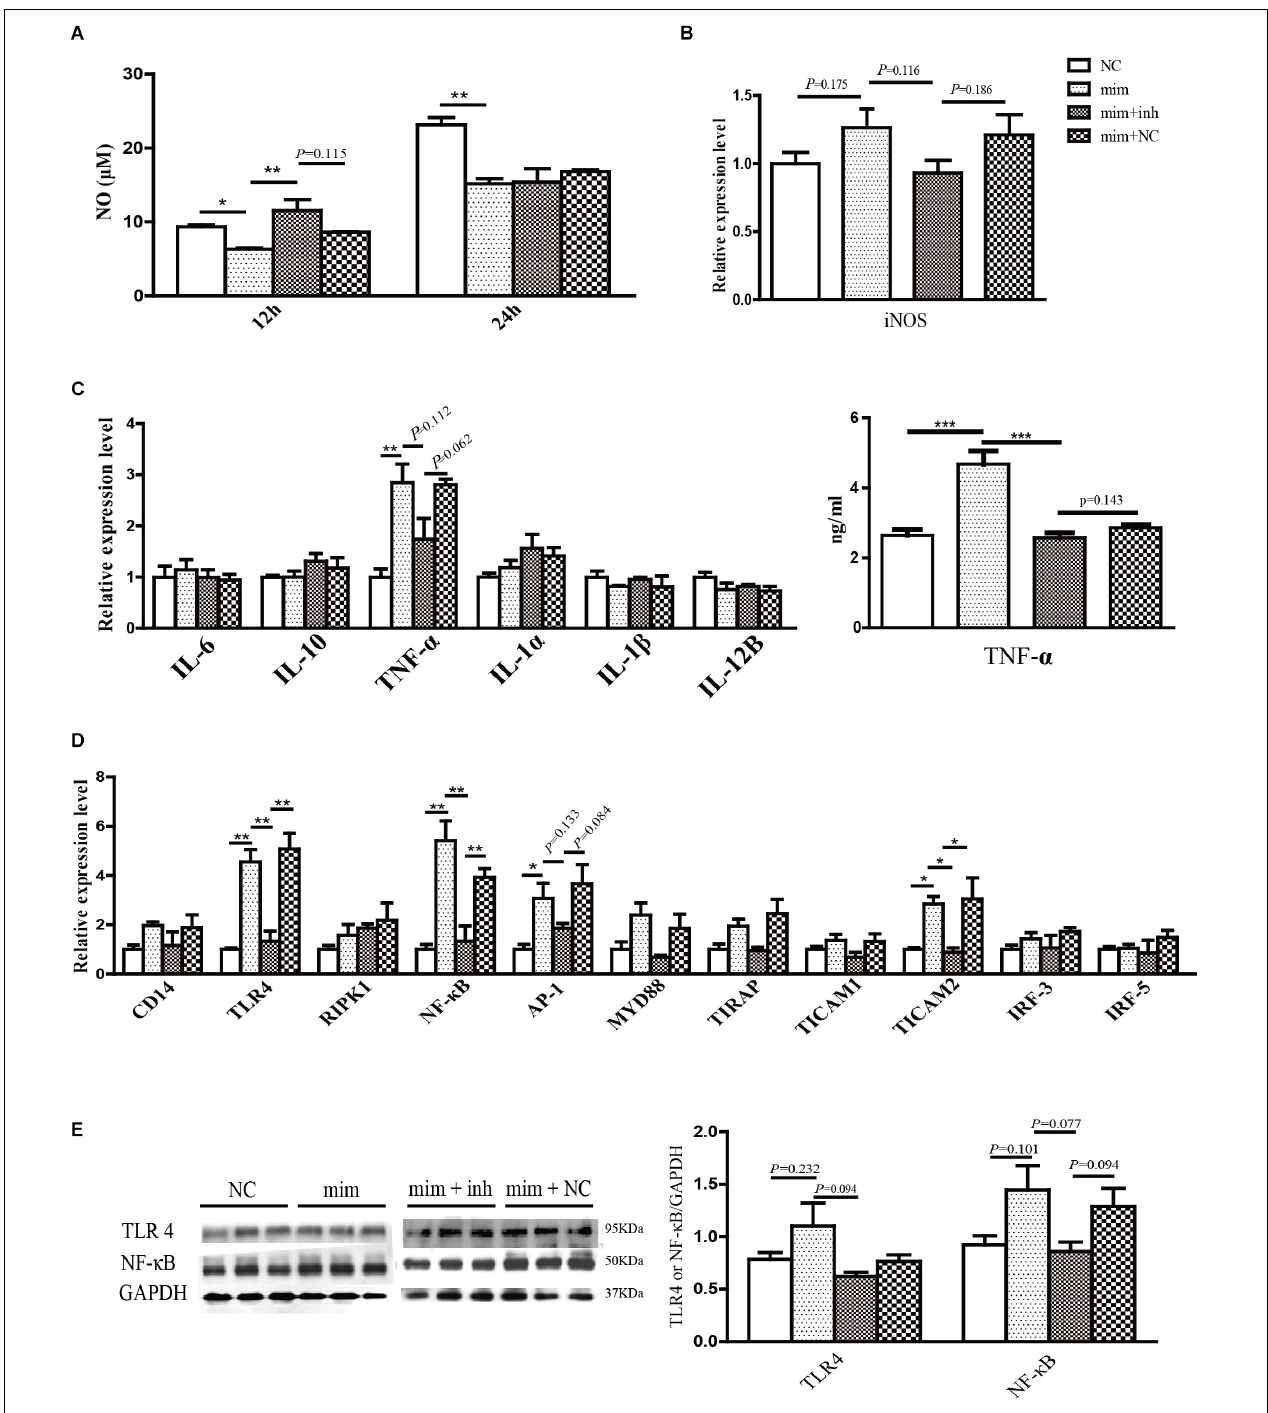
FIGURE 3 | Immunoregulatory effects of emu-miR-4989-3p in the transfected RAW264.7 macrophages. (A) Analysis of NO secretion in the control (NC group), the emu-miR-4989-3p mimics-transfected cells (mim group), the emu-miR-4989-3p mimics-transfected cells after emu-miR-4989-3p inhibitor transfection (mim + inh group) and the emu-miR-4989-3p mimics-transfected cells after control construct transfection (mim + NC group). Data are expressed as mean ± s.e.m.; ∗ p < 0.05, ∗∗ p < 0.01. Data for the final analysis are from three independent experiments. (B) qPCR analysis of inos gene expression. Data are expressed as mean ± s.e.m. Data for the final analysis are from three independent experiments. (C) Analysis of the expression of cytokine genes by qPCR (left panel) and TNF- α by ELISA (right panel). Data are expressed as mean ± s.e.m. ∗∗ p < 0.01, ∗∗∗ p < 0.001. Data for the final analysis are from three independent experiments. (D) Analysis of the expression of eleven key genes on the LPS/TLR4 signaling pathway by qPCR. Data are expressed as mean ± s.e.m.; ∗ p < 0.05, ∗∗ p < 0.01. Data for the final analysis are from three independent experiments. (E) Western blotting analysis of TLR4 and NF- κ B. Data are expressed as mean ± s.e.m.